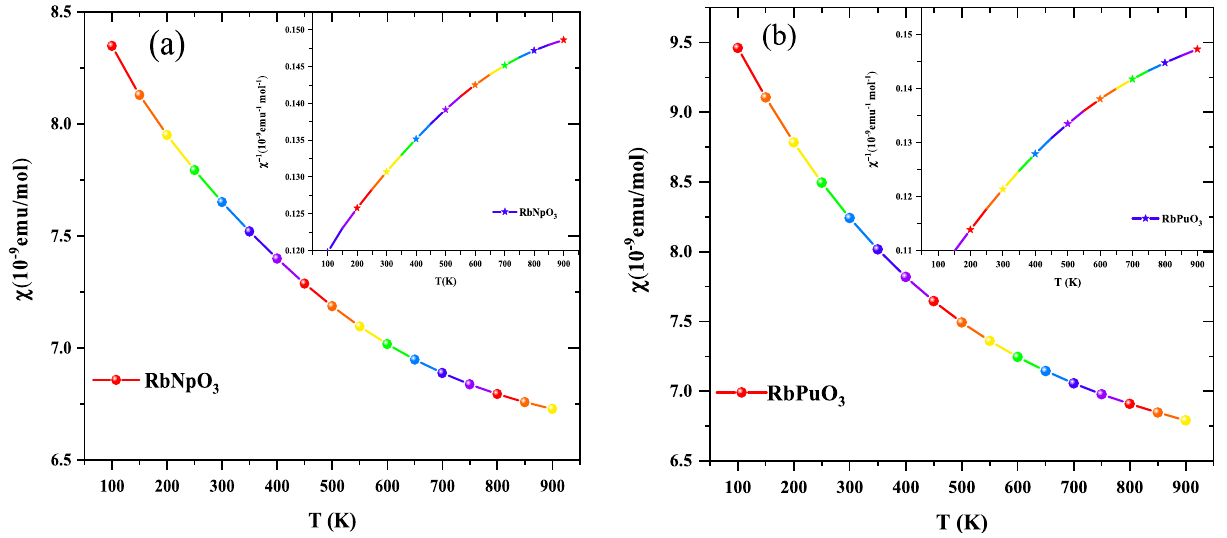
Figure 7. Temperature dependence of magnetic susceptibility ( χ ) and its inverse ( χ −1 ) for ( a ) RbNpO 3 and ( b ) RbPuO 3